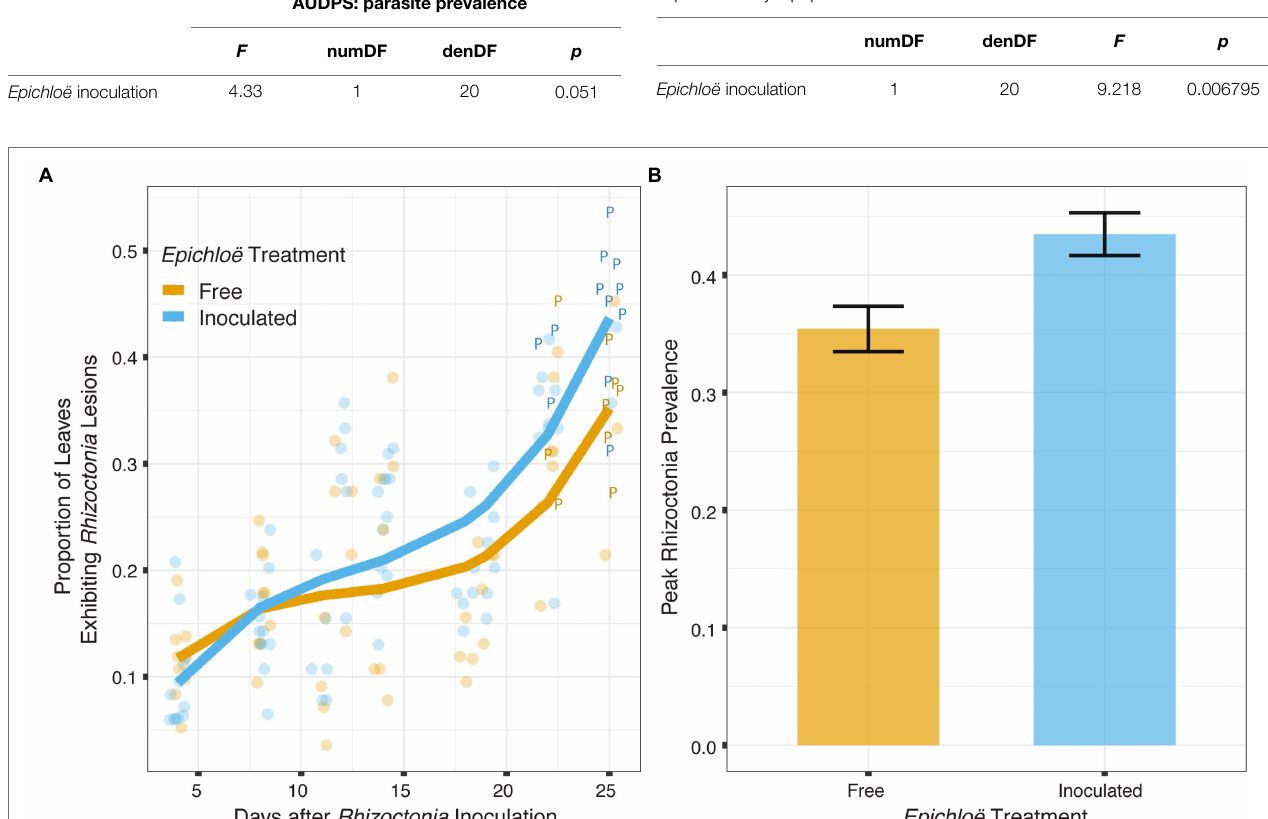
TABLE 3 | Epichloë inoculation clearly increased peak parasite prevalence experienced by a population.